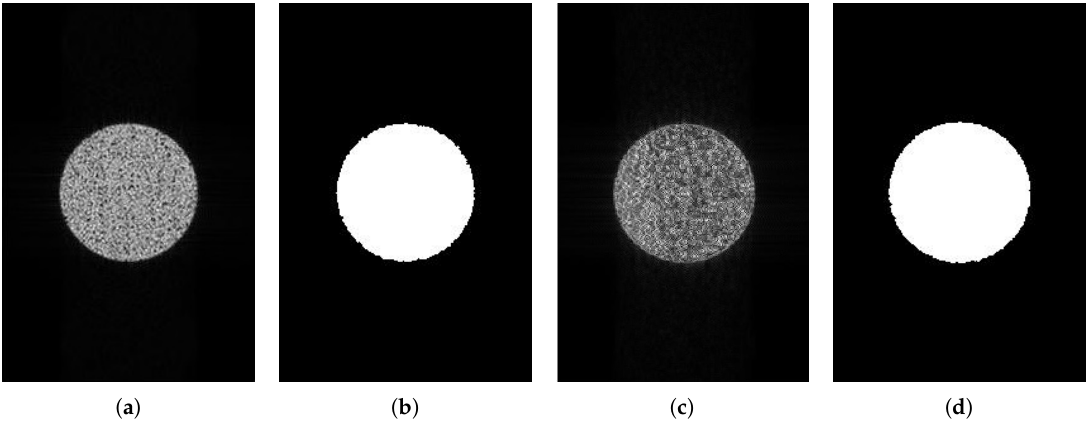
Figure 10. The imaging and image segmentation result of the circular area. ( a ) Original image; ( b ) image segmentation result of the original image; ( c ) edge-enhanced SAR image; ( d ) image segmentation result of the edge-enhanced SAR image.